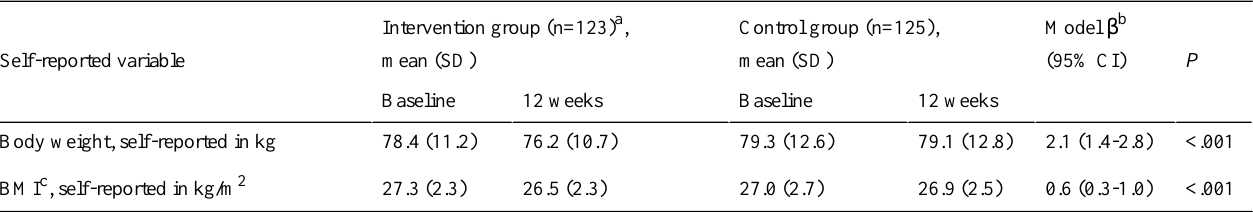
Table 3. Effect of the TXT2BFiT program on self-reported weight and BMI outcomes for all randomized participants in the study by allocation (intention-to-treat analysis) (n=248) a .